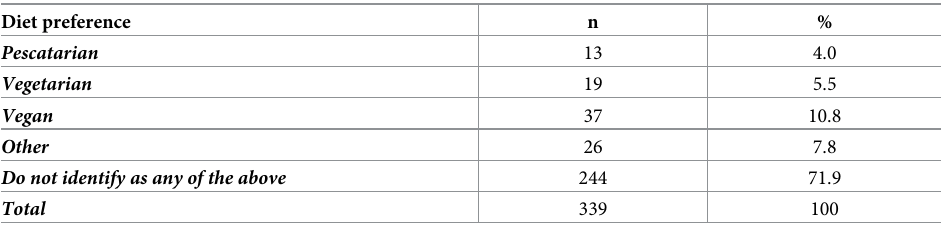
Table 3. Self-reported diet preference.